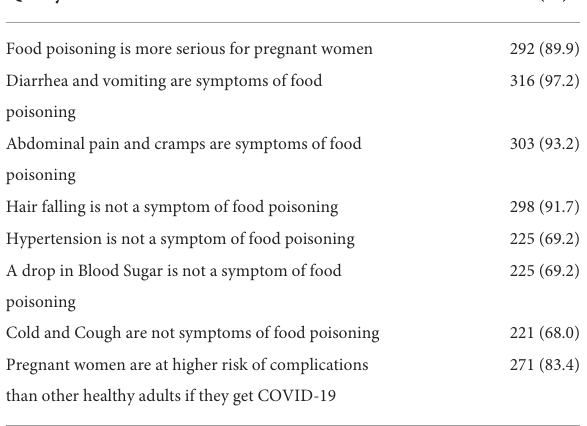
TABLE 9 Association between total food safety awareness score sociodemographic characteristics of participants ( n = 325) a